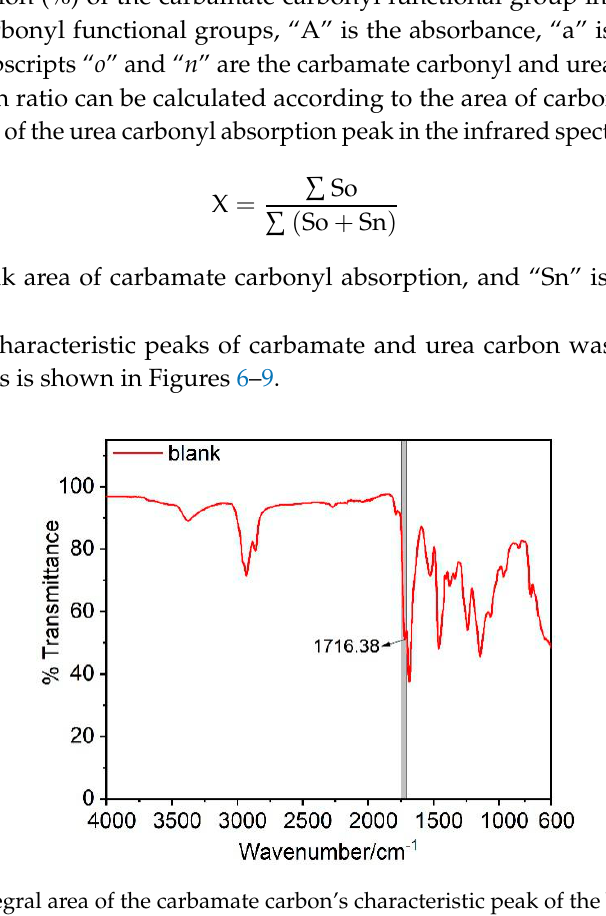
Figure 7. Integral area of the urea carbon’s characteristic peak of the blank sample.